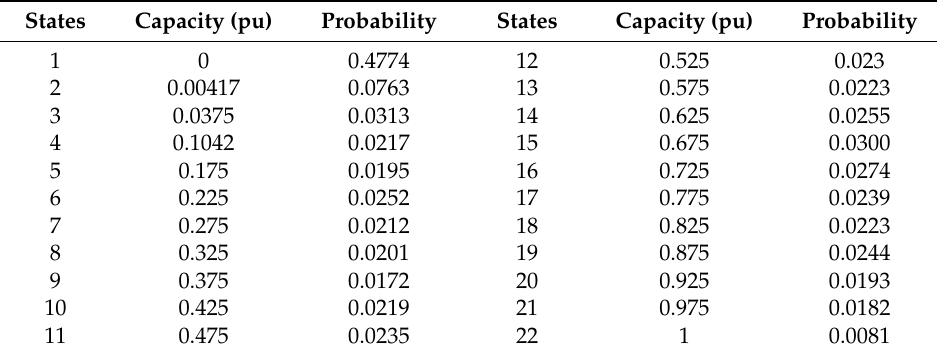
Figure 5. The power output of solar cell. Table 1. Multi-state Model of PV capacity without considering PV system topology.